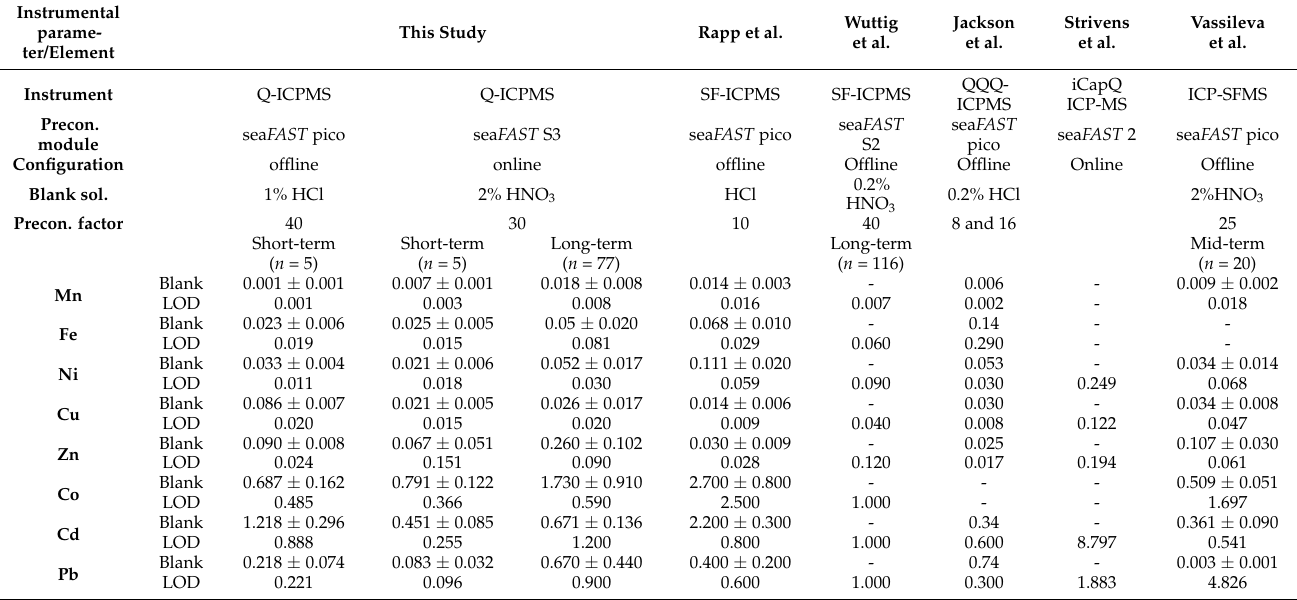
Table 9. Comparison of procedural blanks and LOD’s with literature